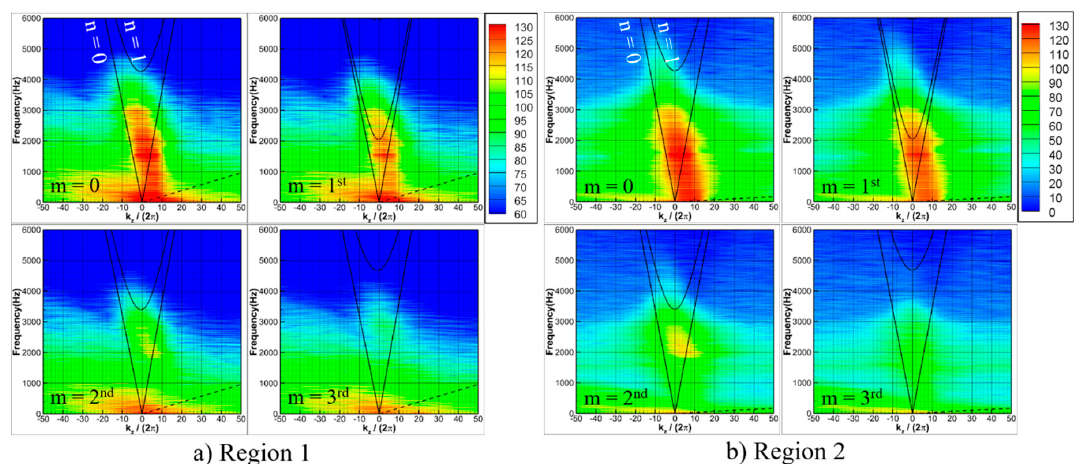
Figure 14. Wavenumber-frequency analysis result; ( a ) Region 1, ( b ) Region 2. n = the radial direction mode; m = the circumferential direction mode.